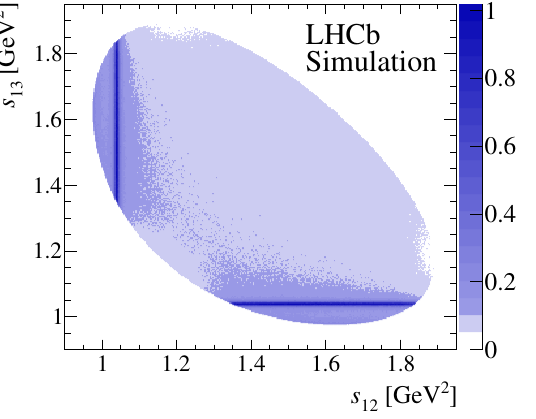
Figure 4 . Projection onto s 1820{1830 MeV.